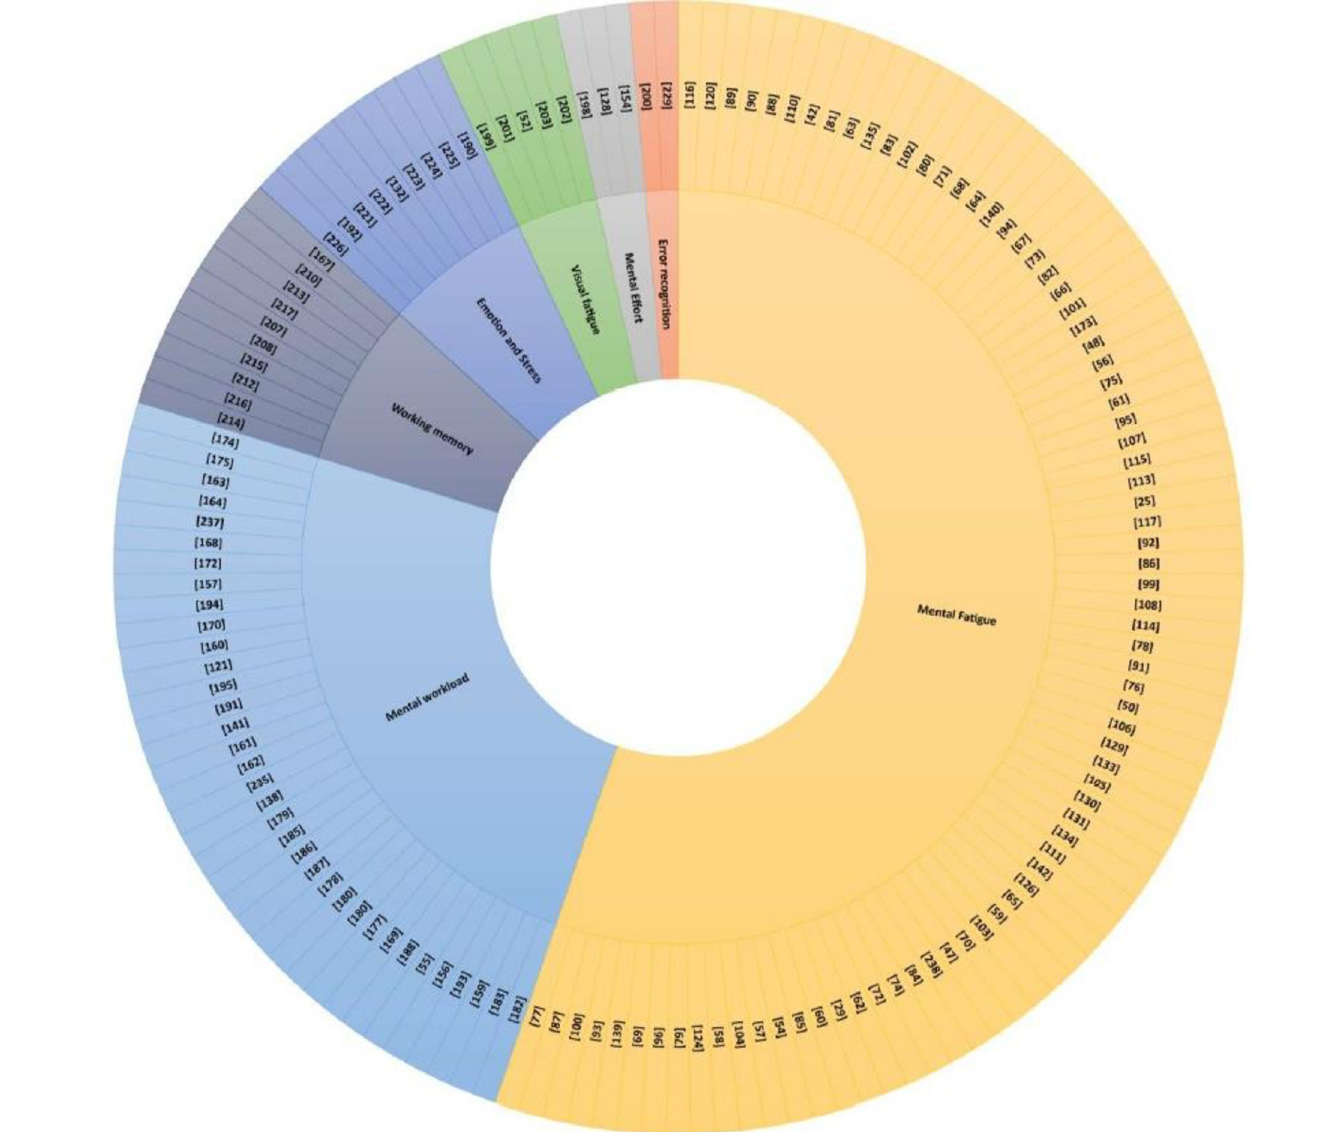
Fig 10. The distribution of 143 articles by performance